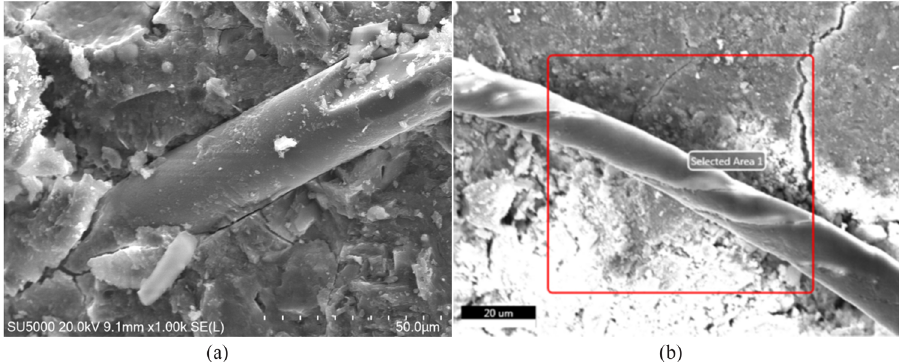
Figure 26: The failure form of BF. ( a ) Drawing failure and ( b ) torsional